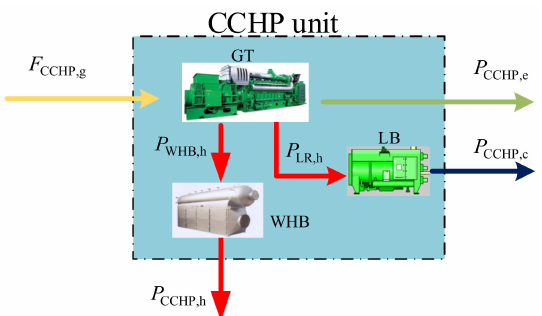
Figure 3. Energy conversion diagram of combined cool heat and power